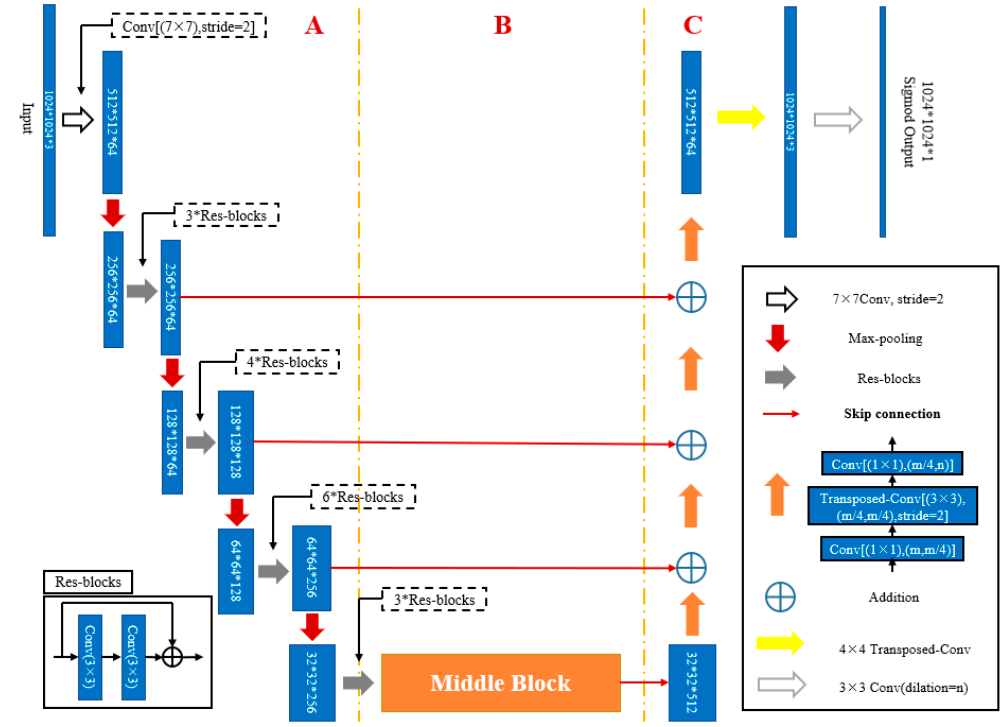
Figure 2. D-LinkNet architecture. Each blue rectangular block represents a multi-channel features Figure 2. D ‐ LinkNet architecture. Each blue rectangular block represents a multi ‐ channel features map.